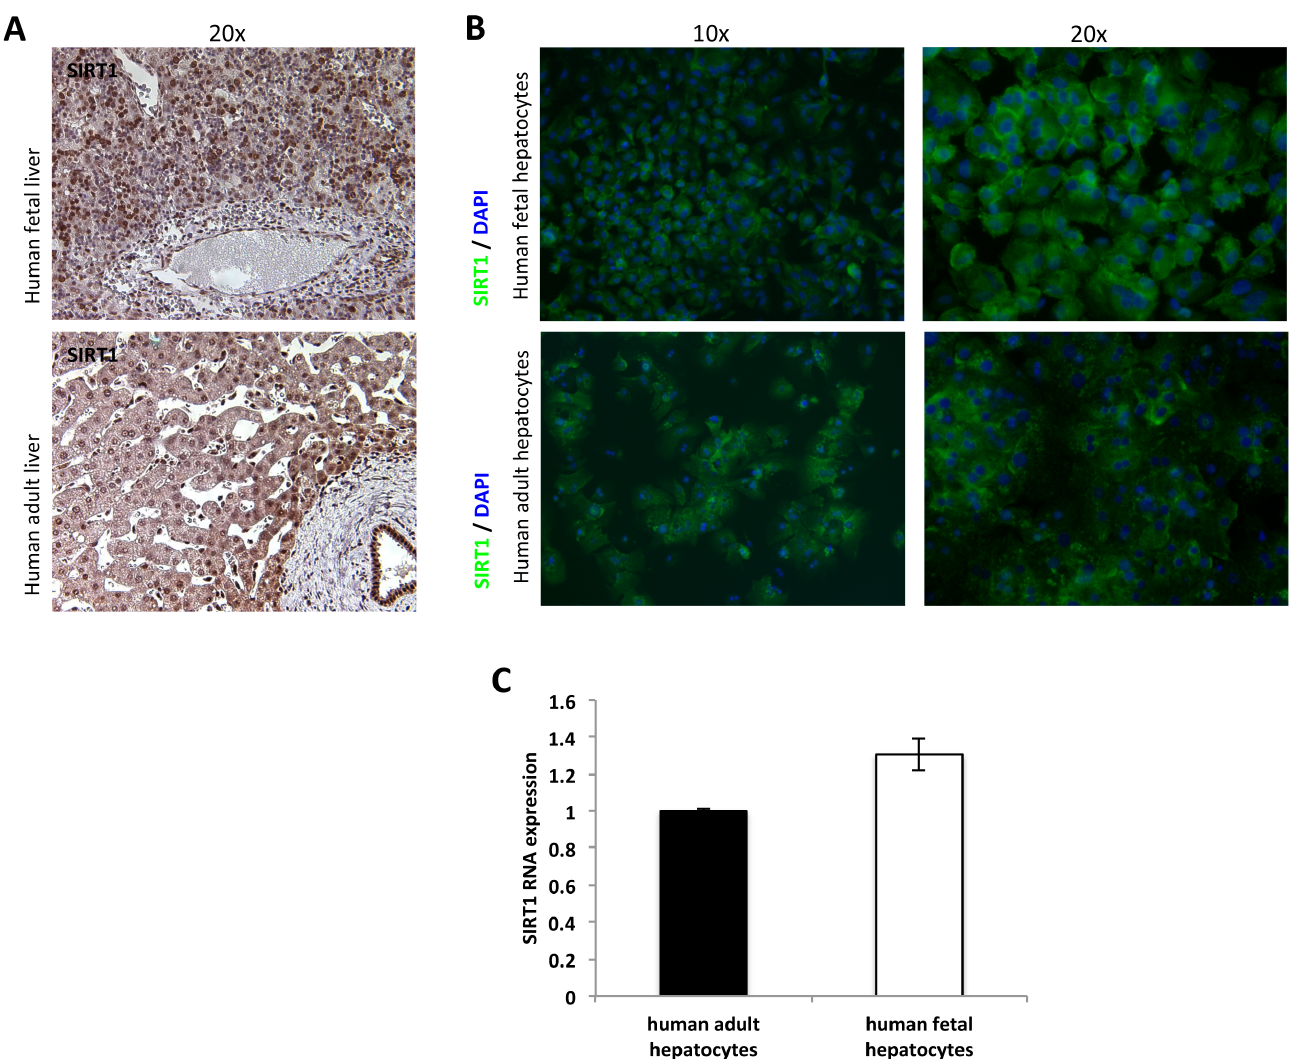
Fig 1. Expression of SIRT1 in human fetal and adult liver and isolated hepatocytes. (A) Immunohistochemistry of SIRT1 in human fetal and adult liver, (B) Immunofluorescence staining of SIRT1 in fetal and adult hepatocytes after 2 days of culture. (C) Quantification of hepatic SIRT1 mRNA expression measured by qRT- PCR in human fetal and adult hepatocytes in vitro and in vivo (n (cid:1)